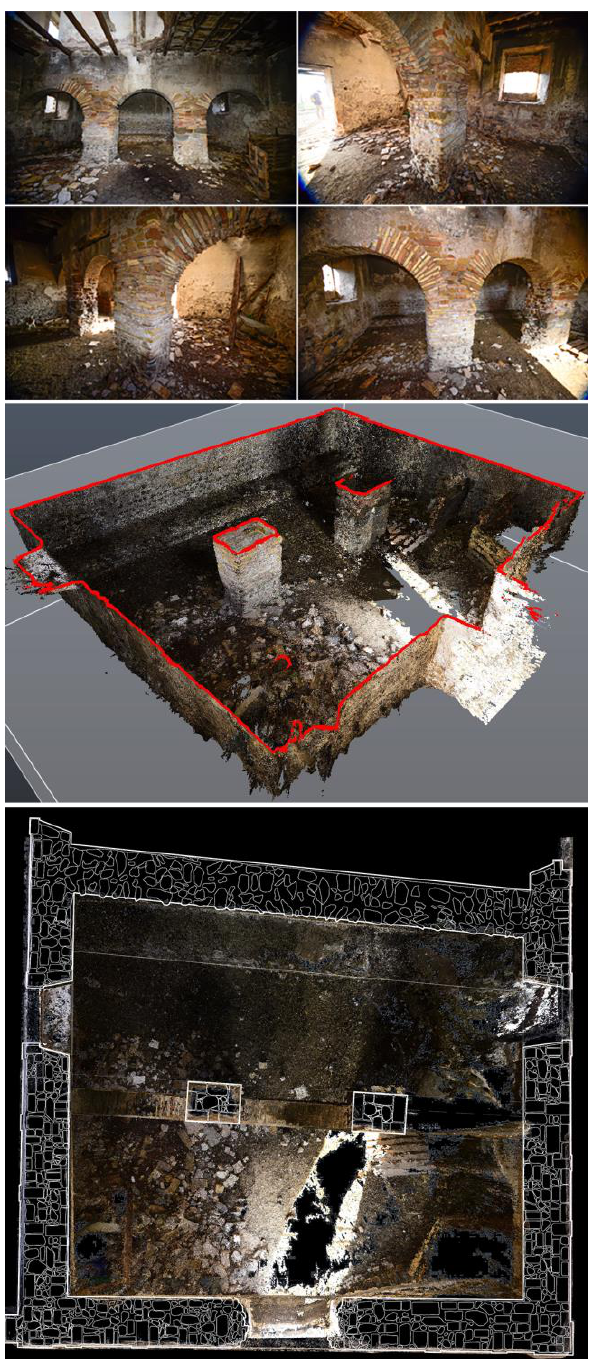
Figure 11. Photomodeling of the sheepfold on the ground floor: two point clouds (external and internal) were connected through the openings. The cloud was used to recreate the geometries of the